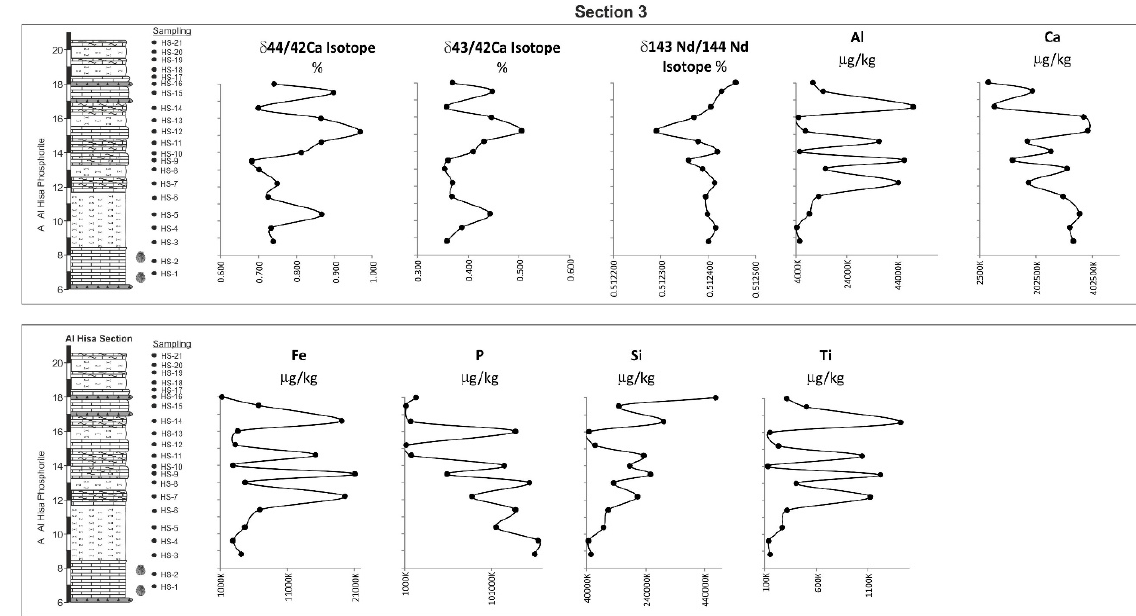
Figure 8. Geochemical data plot against its stratigraphic positions of section 3 samples. The REE patterns, normalized to post-Archean Australian Shale (PAAS; Ref. [39]) are shown in Figure 9.